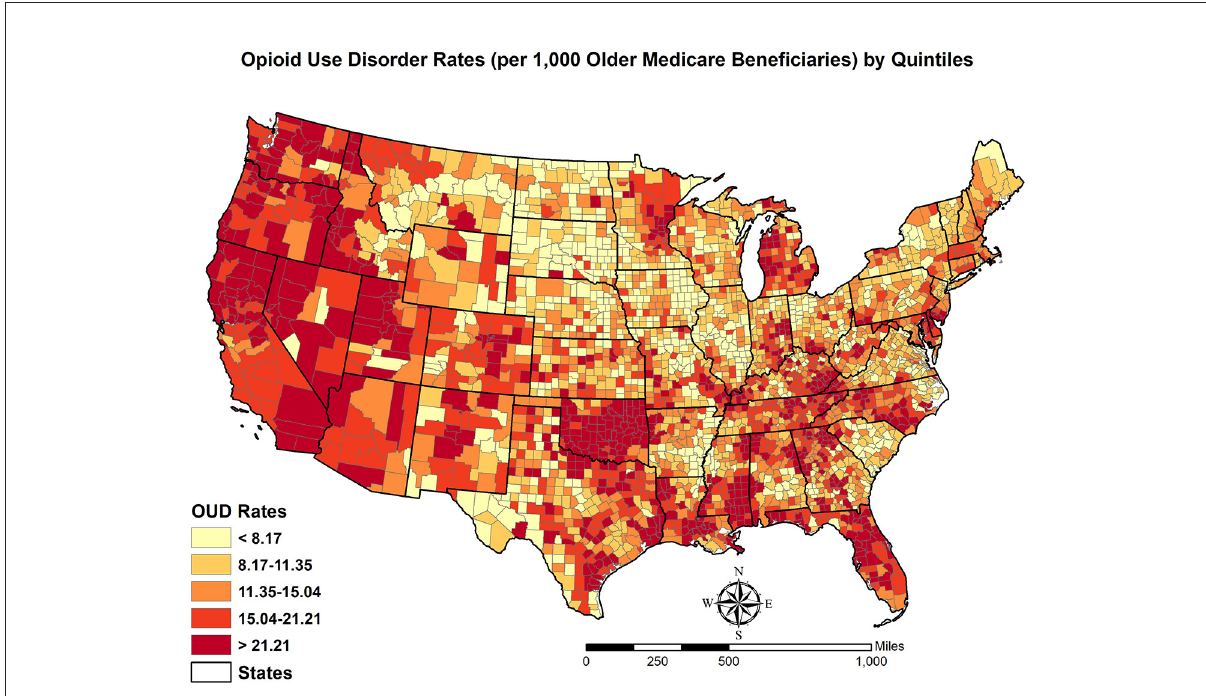
FIGURE1 Spatial distribution of opioid use disorder rates (per 1,000 older Medicare beneficiaries) by quintiles in contiguous US.